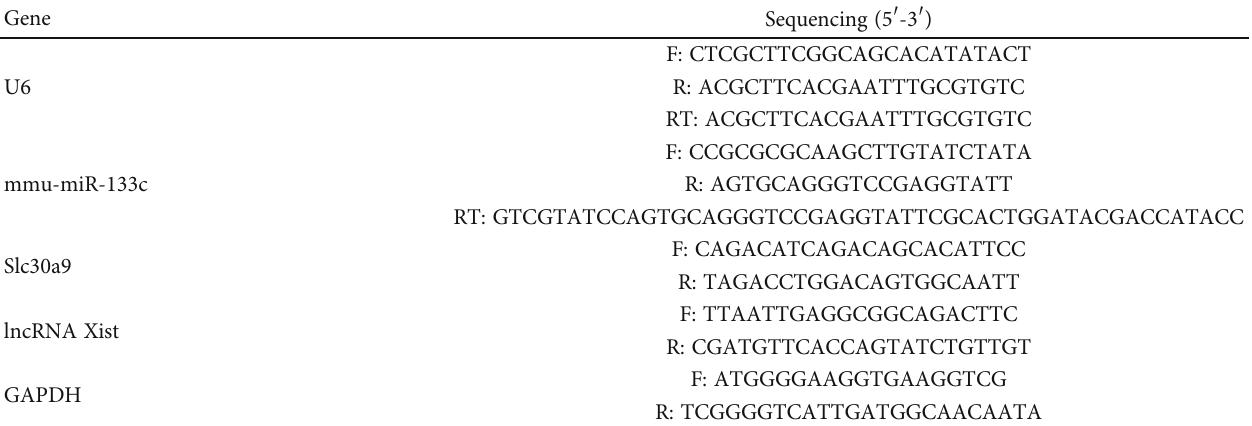
Table 1: Speci fi c RNA primers for quantitative qRT-PCR